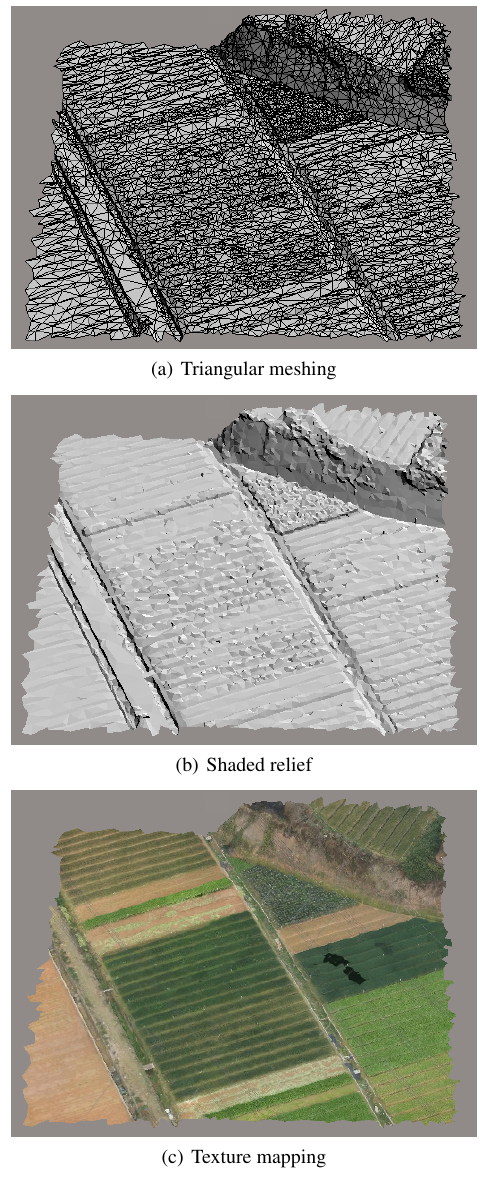
Figure 4. Reconstruction